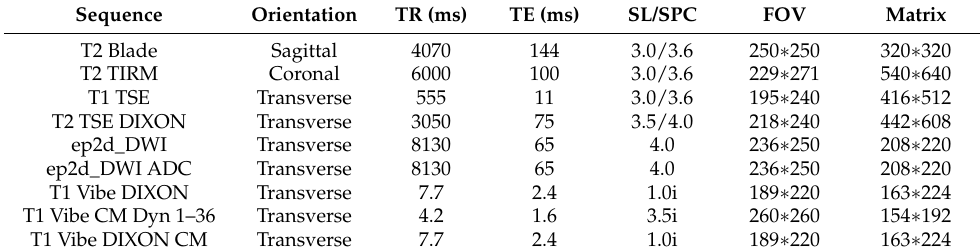
Table 2. Imaging